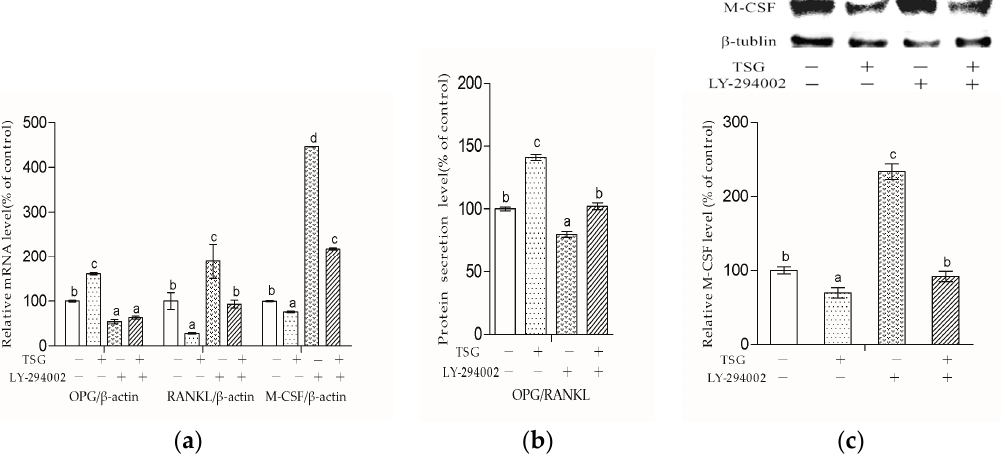
Figure 9. Effect of TSG and LY-294002 on ( a ) the OPG, RANKL and M-CSF mRNA levels, ( b ) the OPG/RANKL protein secretion ratios, and ( c ) the M-CSF protein levels of the MC3T3-E1 cells. Data are represented as the mean ± SD of three determinations. Different letters indicate significant differences ( p < 0.05).